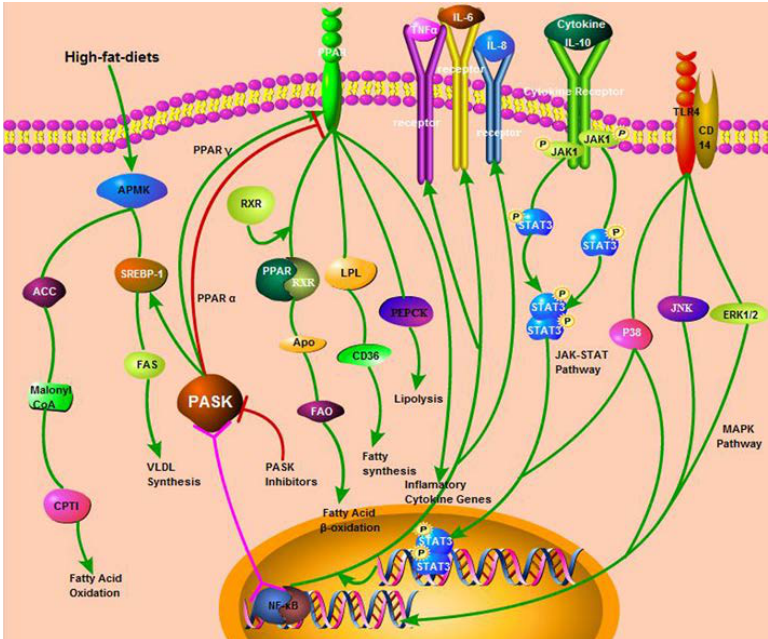
Figure 3. PASK signaling pathways with their downstream targets and direct biological Regulation, PASK has several functions on Lipid metabolism and inflammation. The green line represents active function, the negative effect is in red, and the pink line stands for the uncertain relationship that still needs to be further proven.